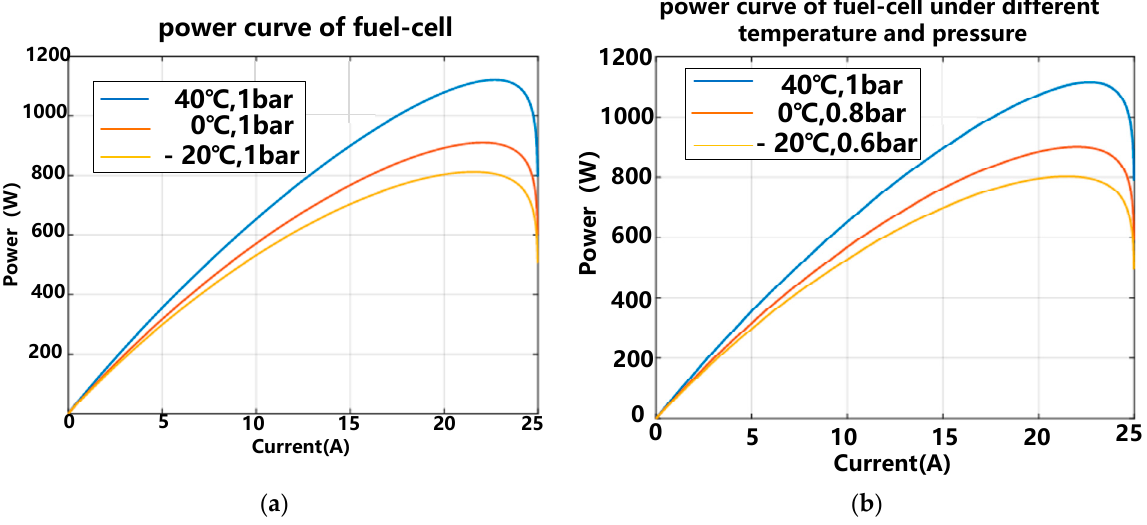
Figure 6. The output power characteristics of fuel cell with different temperatures ( a ) and air pressure ( b ).